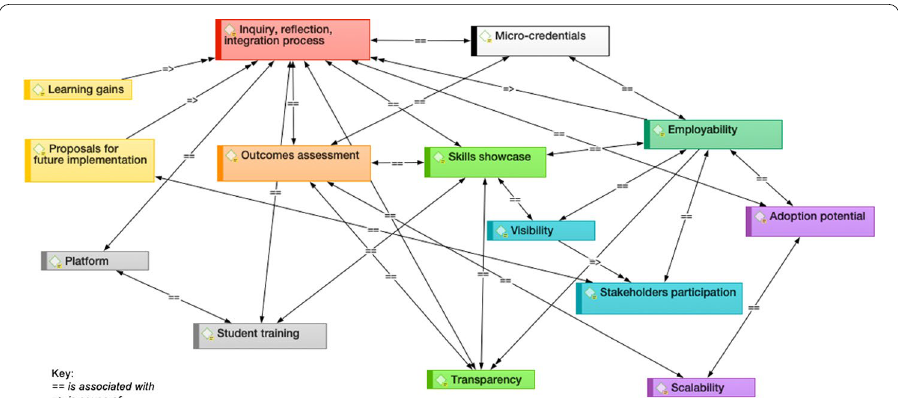
Fig. 7 Network of the semantic linkages between codes emerging from the student data